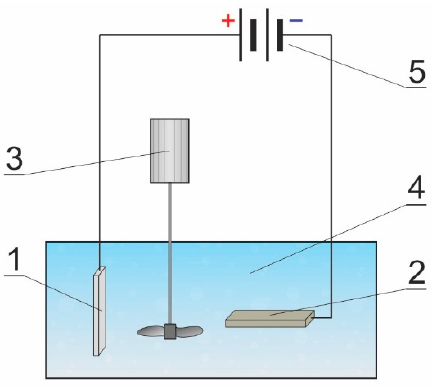
Figure 1. Diagram of the anodizing system used during the production of the oxide layer: 1—aluminum alloy EN AW-5251 (anode), 2—lead plate (cathode), 3—mechanical stirrer, 4—electrolyte, 5—power supply.